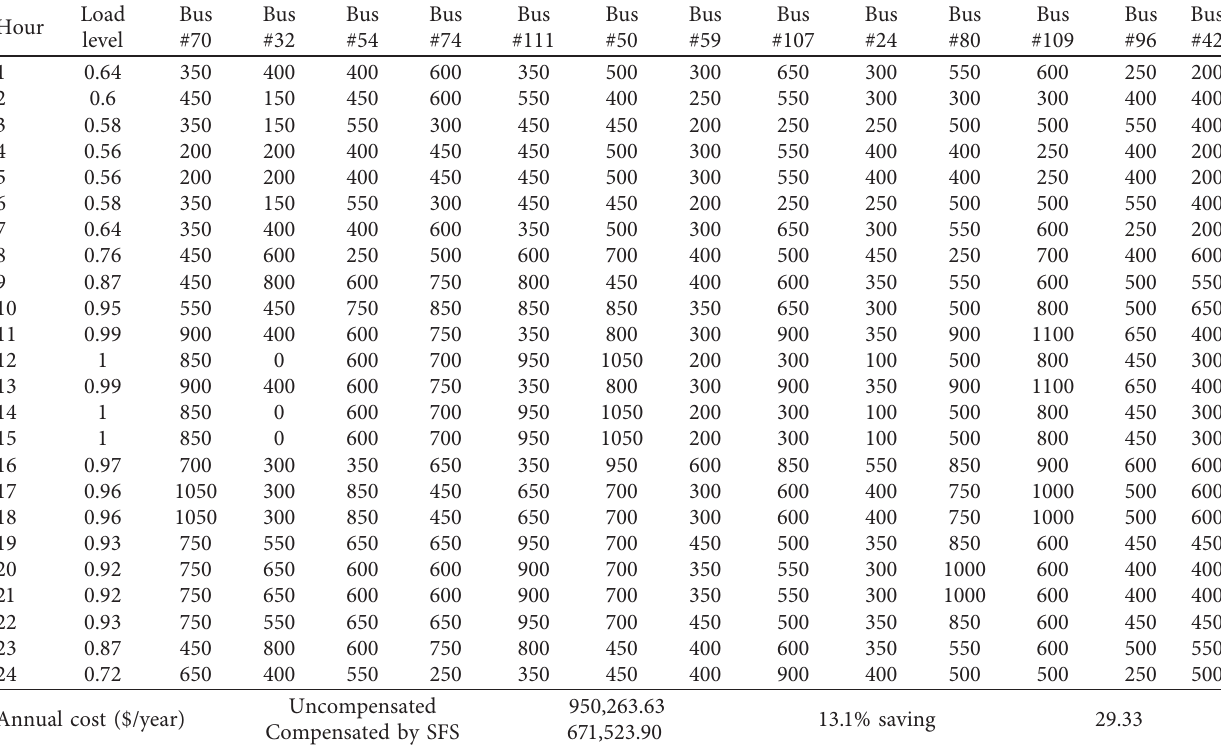
Figure 20: Line current of 119-bus network with 100% loading in scenario 1. Table 9: On/off scheduling of switched SCs by SFS for 119-bus network in scenario